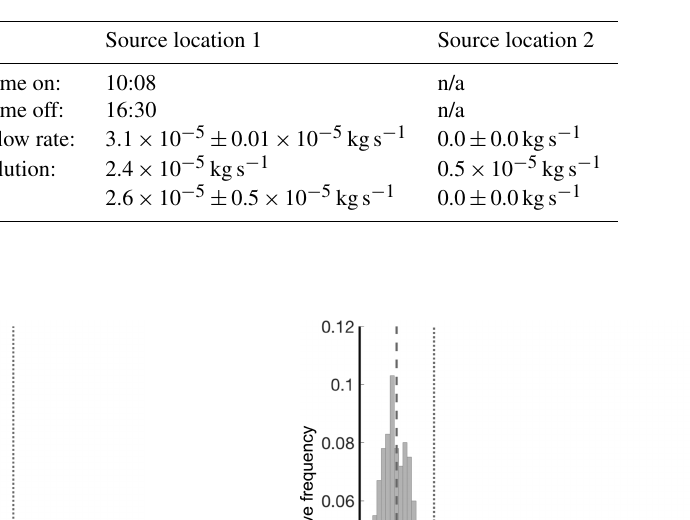
Table 2. Controlled methane release flow rates and 1 standard deviation for each field experiment, including local time that leak was turned on and off.